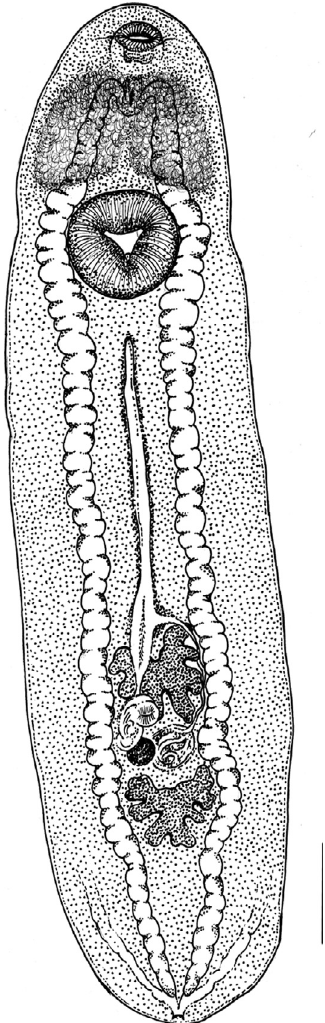
Figure 3. Line drawing of Clinostomum phalacrocoracis metacer- caria. Scale bar = 1